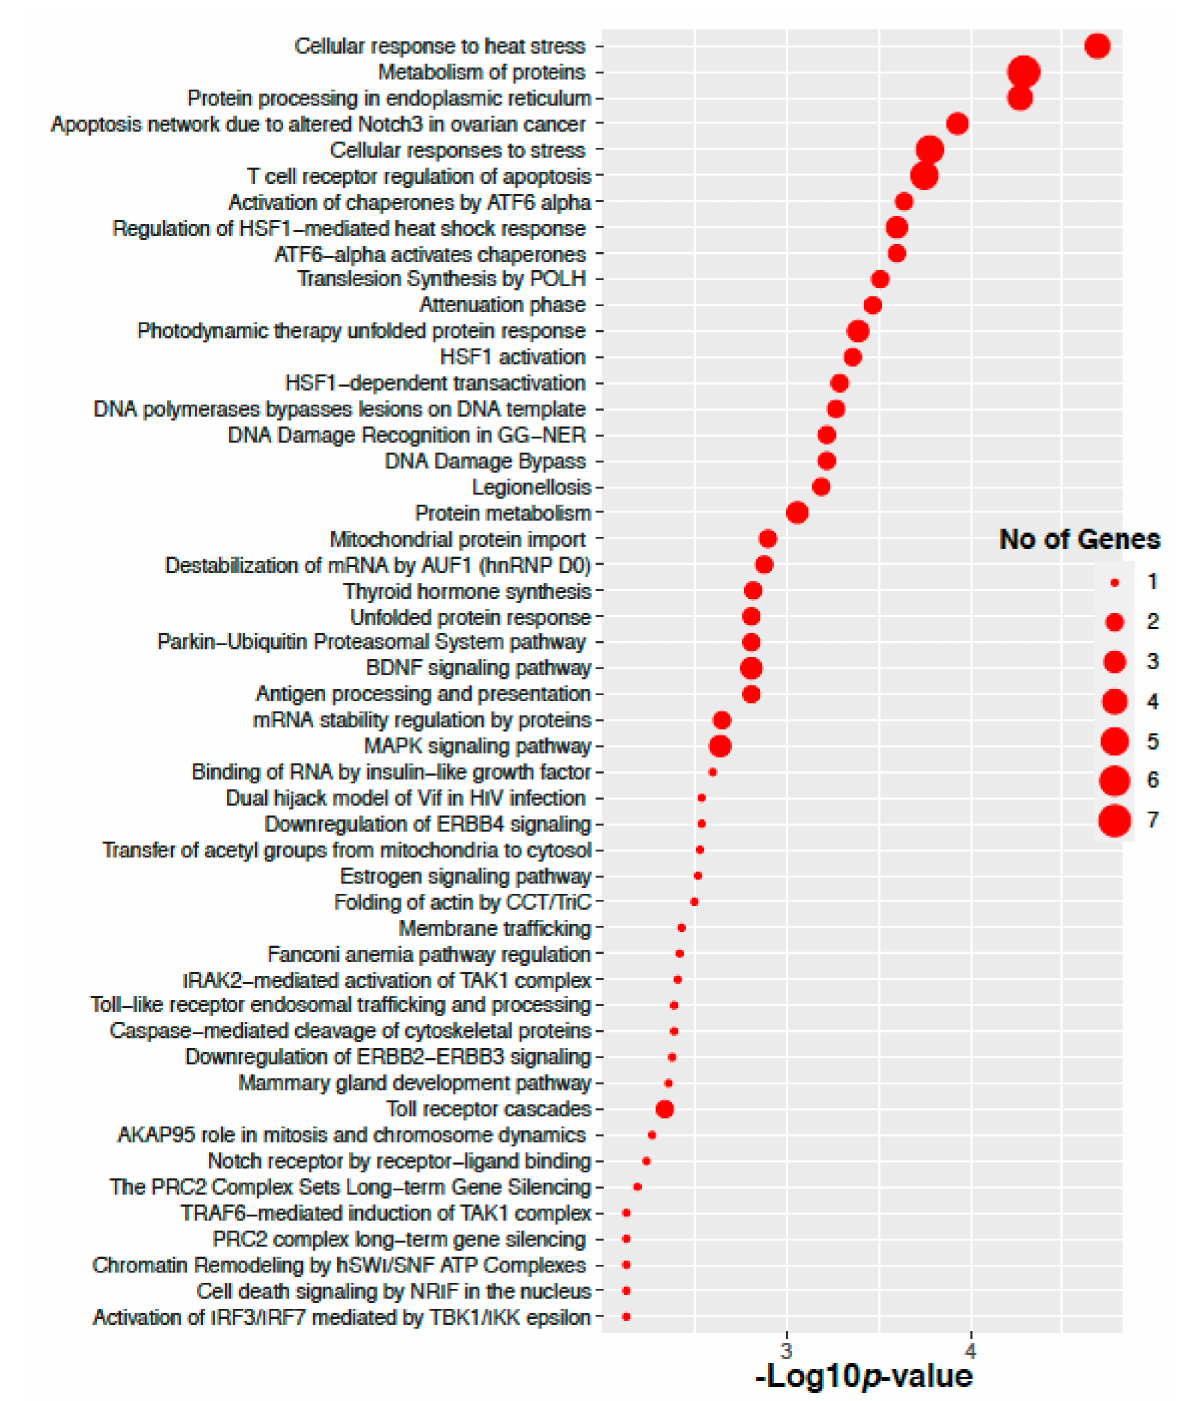
Figure 6. Pathway enrichment of the genes corresponding to the altered 14 proteins in the ovarian